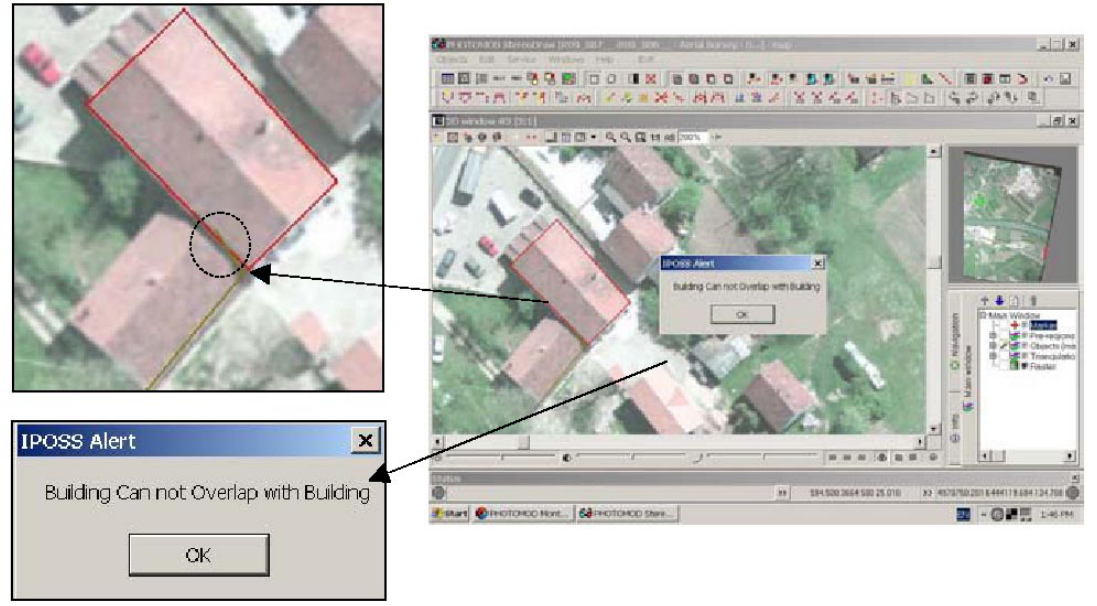
Figure 7. Sample operation of IPOSS